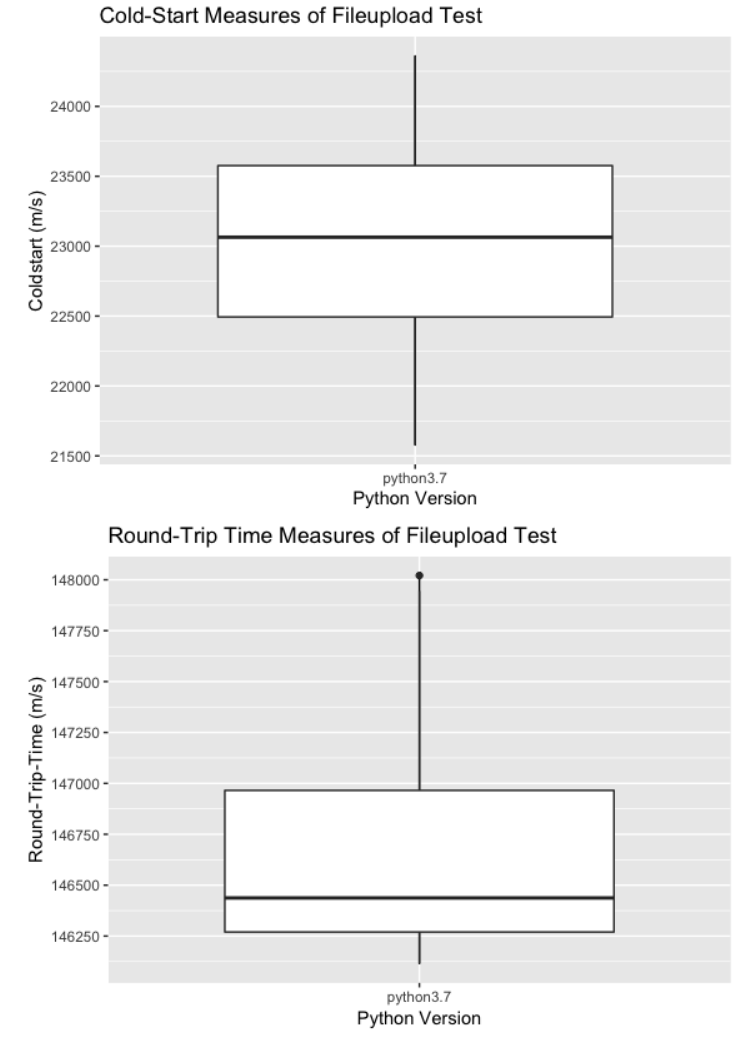
Figure 3. Boxplot of Cold-Start and Round-Trip-Time Results for integrated Fileupload Stream. Scale Test: The Scale Test run with the integrated file upload streams results in 112 observations and 112 unique functions, with 56 measurement functions per memory size. Each function instance was invoked between 0 and 10 times. The varying timestamps in the dataset indicate that all